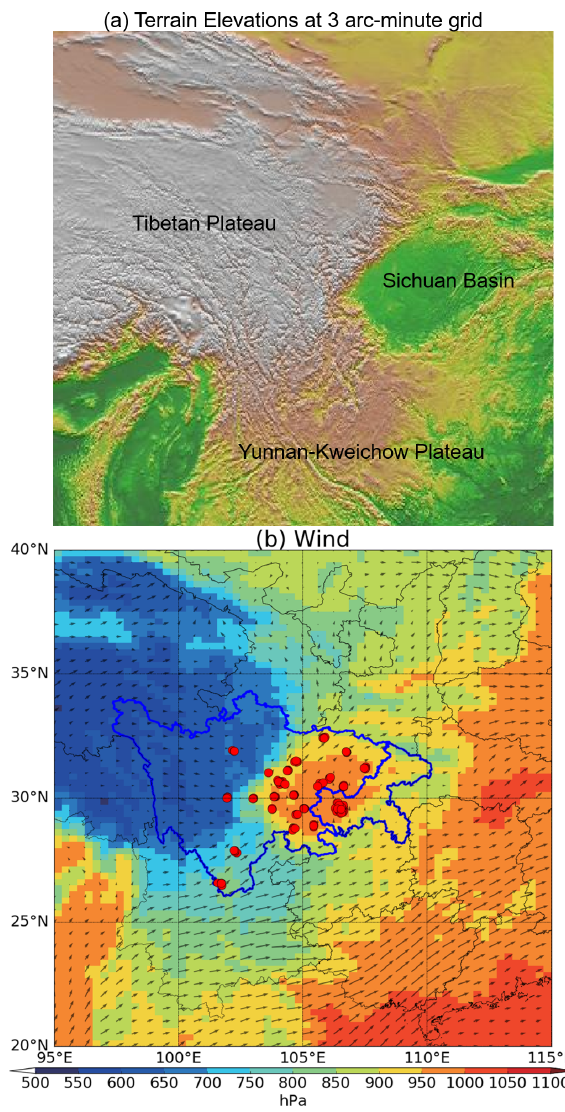
Figure 5. Terrain elevations (a) and surface temperature and wind fields (b) over the SCB and surrounding regions. The spatial reso- lutions for panels (a) and (b) are 3 × 3arcmin and 0.25 ◦ × 0.25 ◦ respectively. In panel (a) , the white area is the Tibetan Plateau (with altitudes of 4–5kma.s.l.), the yellow area is the Yunnan– Kweichow Plateau (2–3kma.s.l), and the green area is the SCB (0.5–1kma.s.l). The base map of the figure was created using the Basemap package in